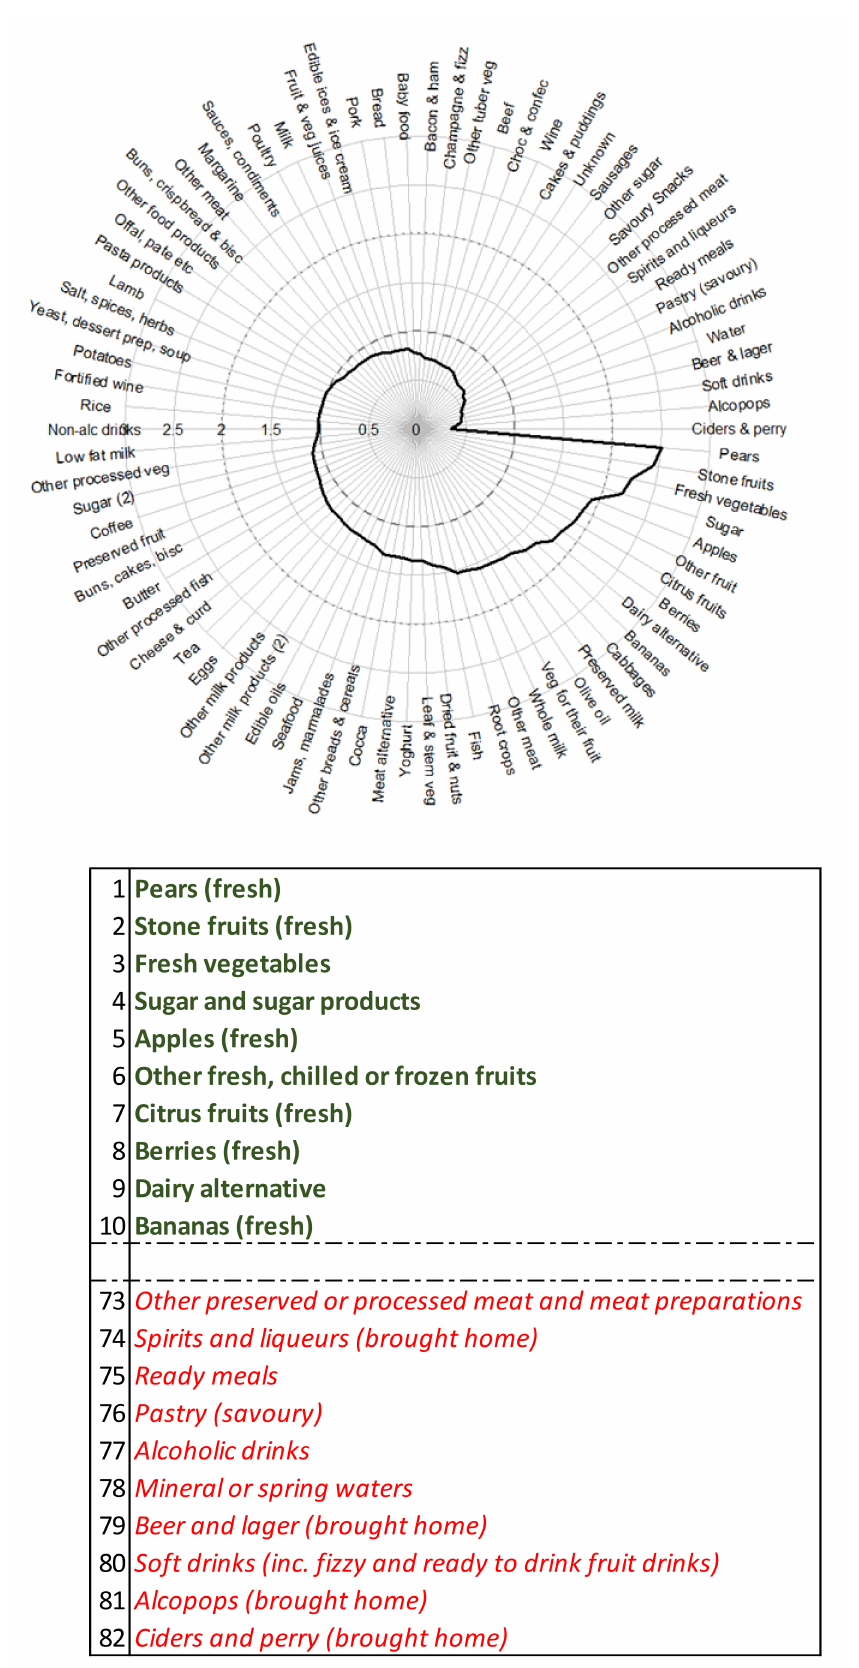
Figure A1. Fruity ( n =